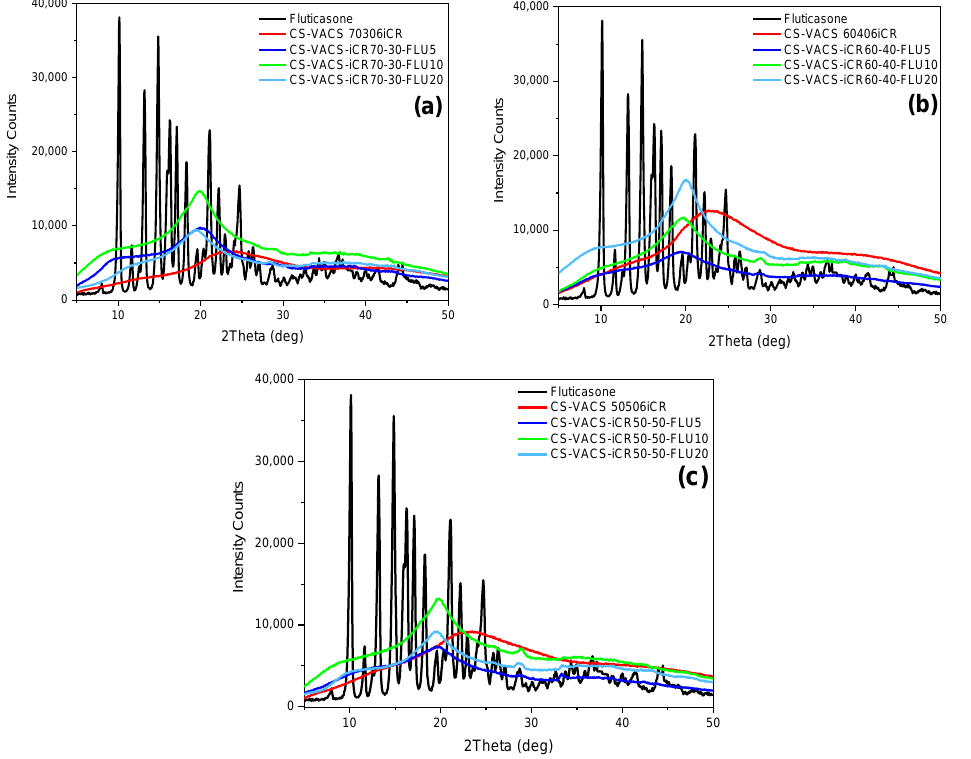
Figure 9. XRD diffractograms: ( a ) CS/VACS/iCR 70/30, ( b ) CS/VACS/iCR 60/40, and ( c ) CS/VACS/iCR 50/50, containing FLU in different ratios 5%, 10% and 20% w / w .